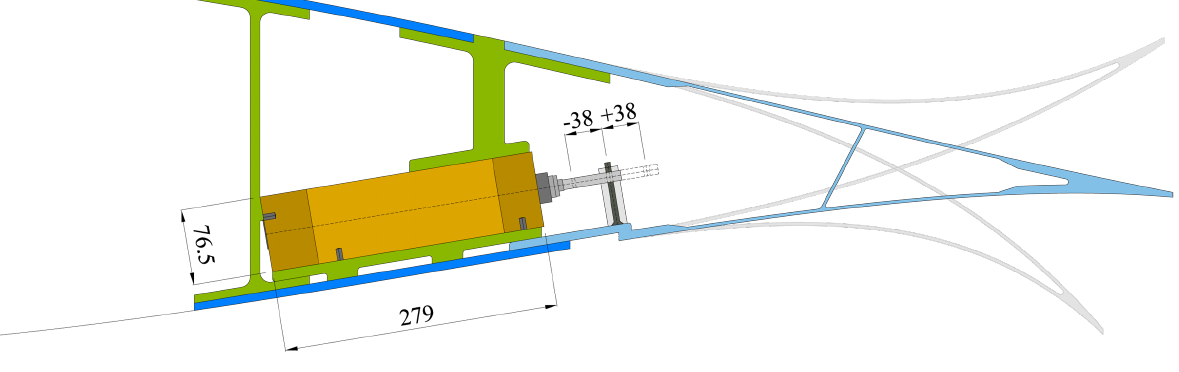
Figure 19. CAD model of the selected actuator installed inside the wing section.